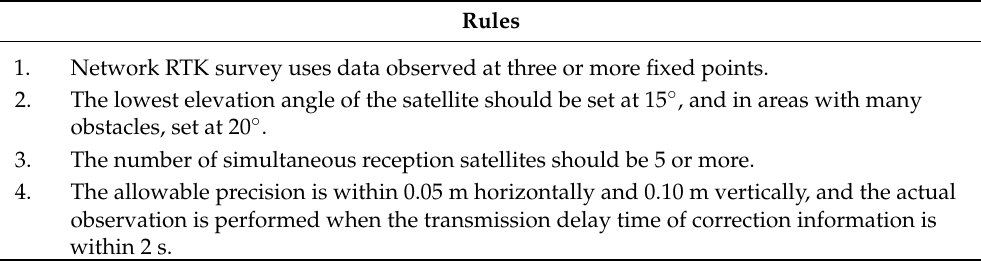
Figure 2. Arrangement of GCPs and CPs of the study site. Table 3. Synopsis of the RTK public surveying work regulation.